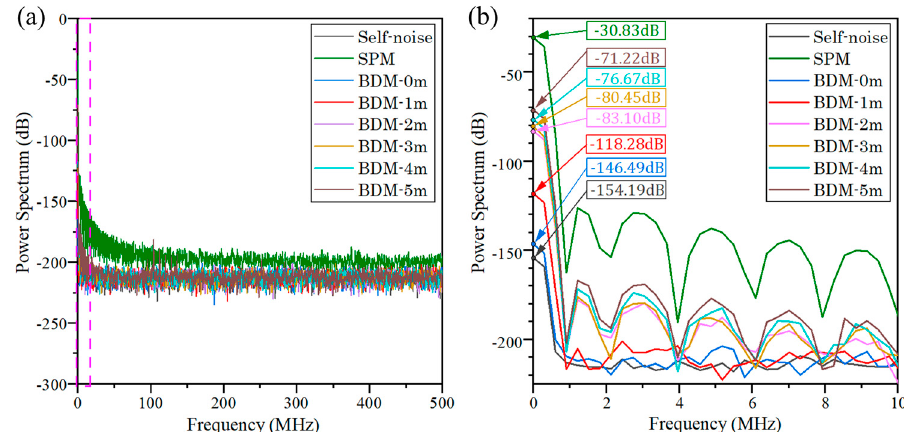
Figure 5. Power spectra of circuit self-noise and background noise measured by BDM with different lengths of differential extension lines in the frequency band of ( a ) 0~500 MHz and ( b ) 0~10 MHz.